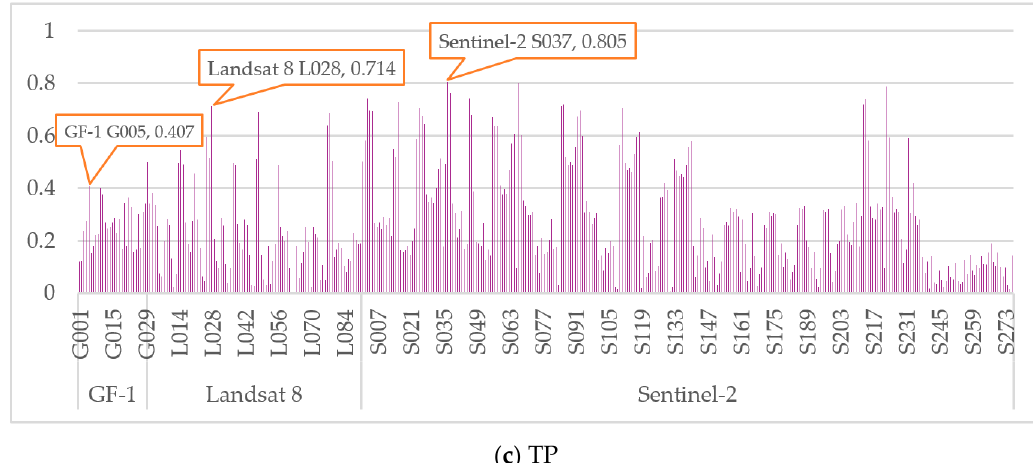
Figure 10. Distribution of the correlation coefficient between different band combinations and water quality parameters (NH 3 -N, COD and TP). The X -axis is the number of single bands and band combinations. G001, G002, ⋯ , G028 and G029 are the numbers of the four multispectral bands and band combinations of the GF-1 satellite. L001, L002, ⋯ , L090 and L091 are the numbers of the seven multispectral bands and band combinations of the Landsat 8 satellite. S001, S002, ⋯ , S275 and S276 are the numbers of the seven multispectral bands and band combinations of Sentinel-2 satellite. The Y -axis is the R value. The labels in the figure are the band combination numbers and R values of the highest correlation between di ff erent satellite sensors and NH 3 -N, COD and TP. ( a ) NH 3 -N; ( b ) COD; ( c )